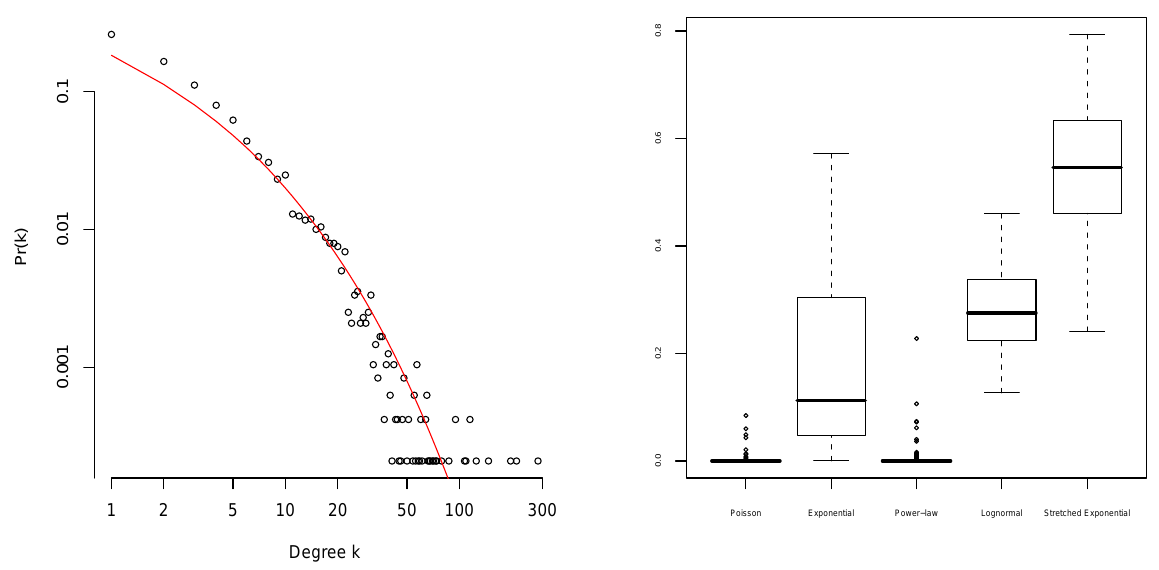
Figure 2: Empirical degree distribution of present yeast PIN dataset (black circles) and bagged MMI estimate for the degree distribution resulting from 200 bootstrap replicated of the degree dis- tribution of a subnet containing 200 nodes. The boxplot shows the distribution of Akaike weights for the different models in table 1. Note that classical powerlaws, against expectation, appear to capture relatively little information contained in the degree